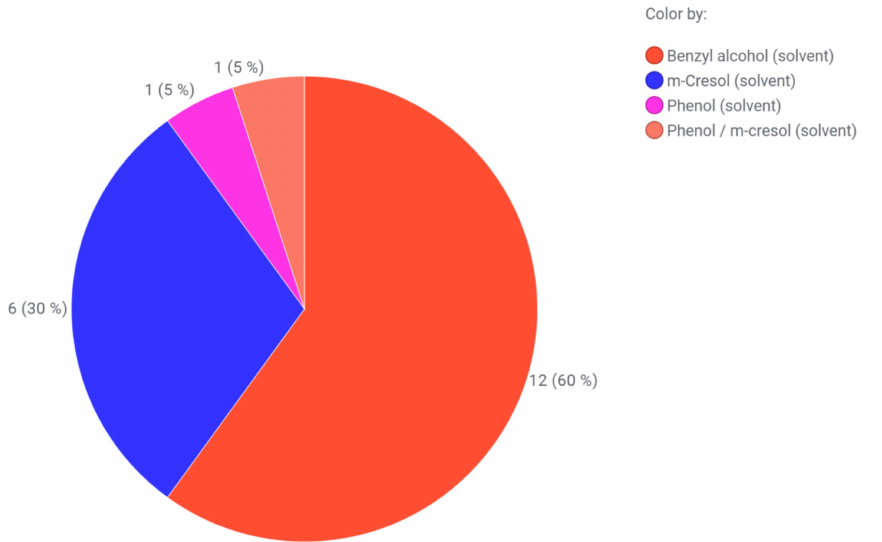
Figure 6. Preservative distribution in licensed protein, peptide, or antibody formulations containing bacteriostatic water.